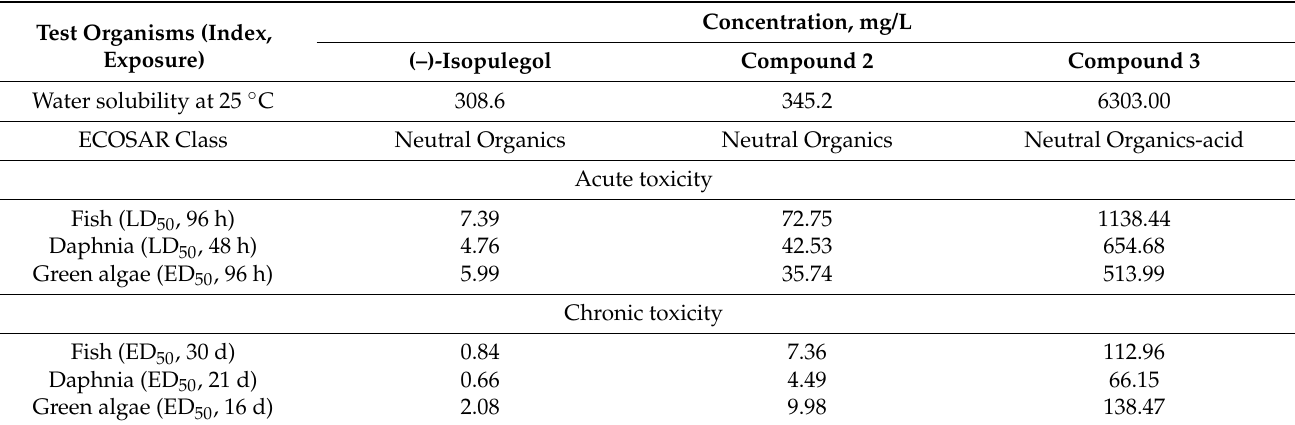
Table 2. Estimated ecotoxicity and solubility of (–)-isopulegol and its derivatives.